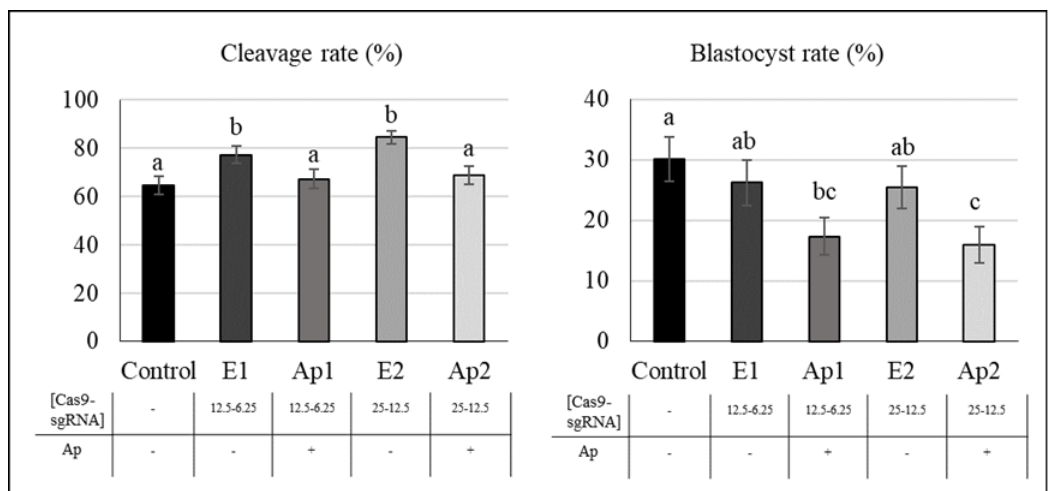
Figure 5. Effect of aphidicolin and ribonucleoprotein concentration in porcine embryo development. Figure shows cleavage and blastocyst rate of in vitro matured oocytes electroporated with 12.5 ng/ µ L Cas9 protein plus 6.25 ng/ µ L sgRNA and incubated without (E1) or with 0.5 µ M aphidicolin (Ap1), electroporated with 25 ng/ µ L of Cas9 protein and 6.25 ng/ µ L of sgRNA and incubated without (E2) or with aphidicolin (Ap2), and Control group without electroporation or aphidicolin. Ap: aphidicolin; Cleavage rate (%): Two-cell embryos per total number of inseminated oocytes. a–c Values with different superscripts are significantly different ( p < 0.05). Table 1. Two-way ANOVA analysis for the effect of aphidicolin and ribonucleoprotein (Cas9/sgRNA) concentration